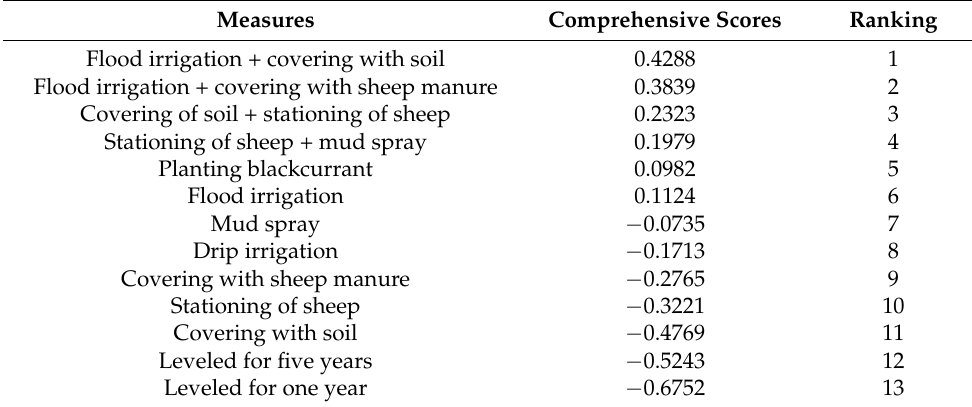
Table 2. Comprehensive score and ranking of various recovery